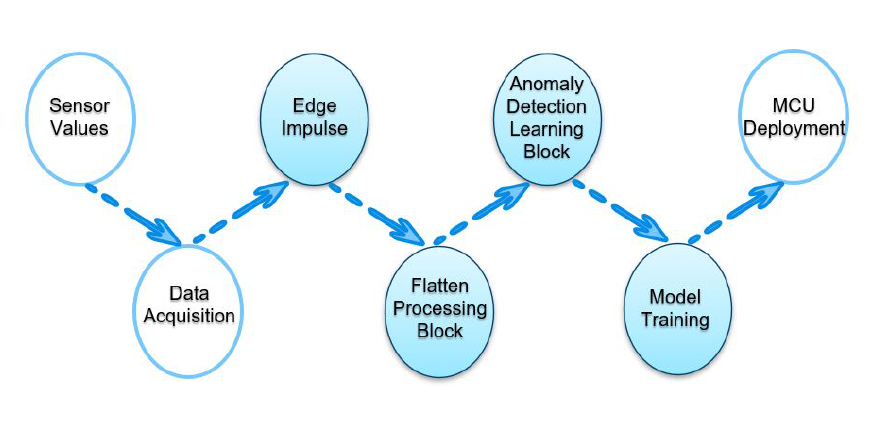
Figure 4. The Model’s Training Procedure.